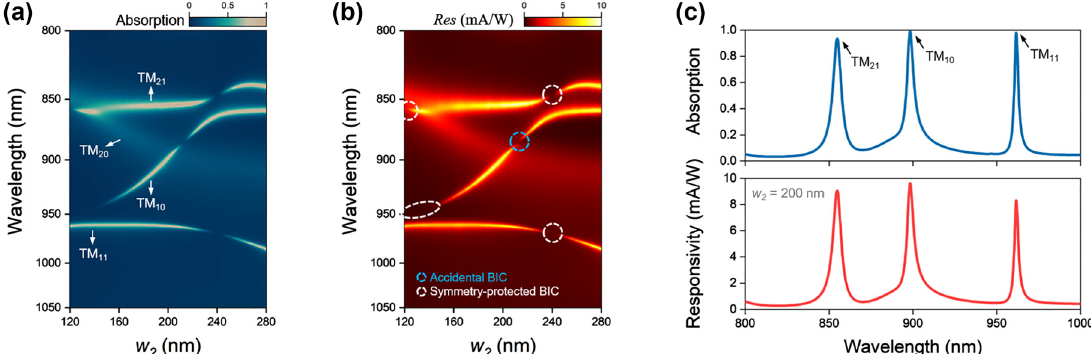
Figure 5: Multiband HEPD enabled by quasi-BICs and guided resonance. (a) Absorption and (b) responsivity spectra of plasmonic structure with different w 2 at normal incidence. Symmetry-protected and accidental BICs are marked with white and blue dashed circles in b, respectively. (c) Absorption and responsivity spectra of grating structure with w 2 = 200 nm. Here, w 1 and gap are fi xed at 120 achieve multiband light harvesting. As w 2 = 213 nm, the further increased to 240 nm while retaining a lattice con- linewidth of TM mode disappeared due to the generation symmetry is reobtained due to the stant a = 600 nm, C 10 2 of an accidental BIC in a con fi guration without C continuous translational symmetry of the structure. In this sym- 2 condition, the distance separating the ridges is the same in metry, marked as a blue circle in Figure 5b. When w 2 is